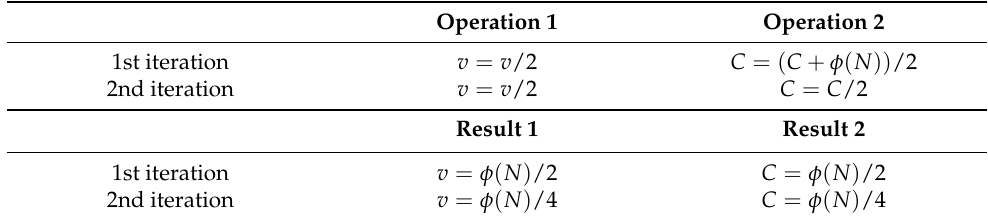
Table 1. Target operations on BEEA ( e , φ ( N )